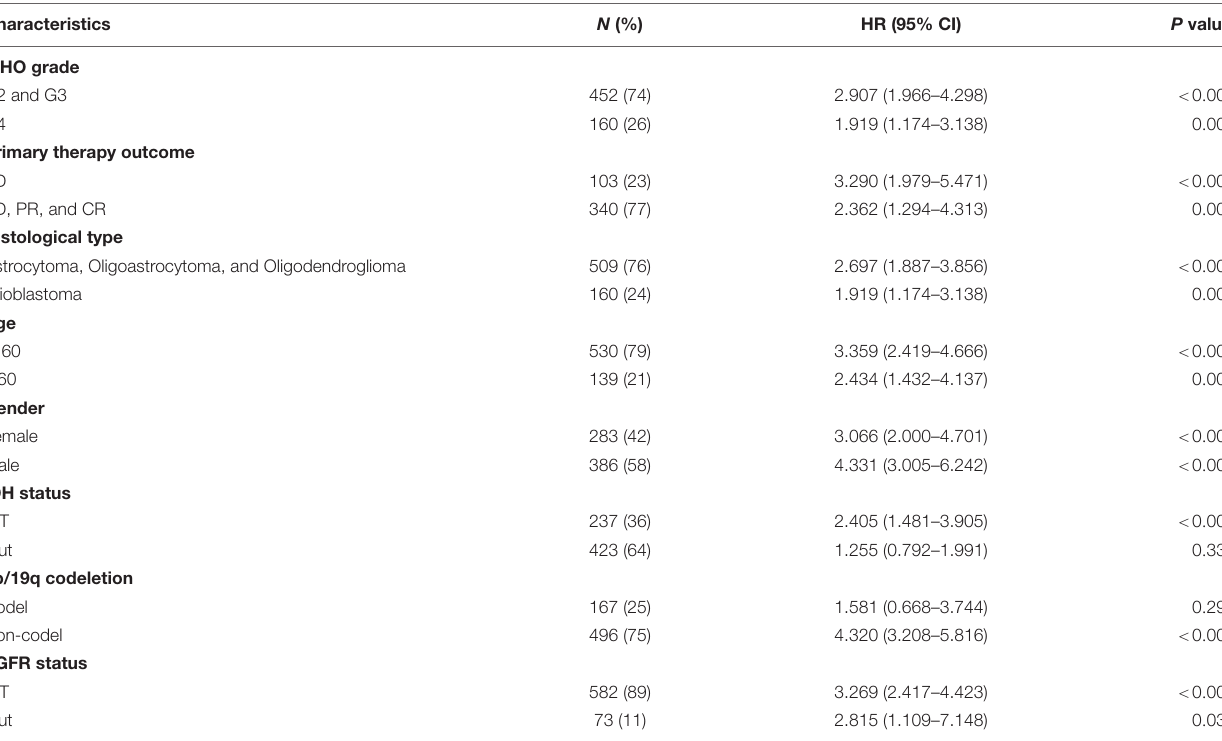
TABLE 4 | Correlation of IER5 expression and clinical prognosis in glioma patients with different clinicopathological characteristics.